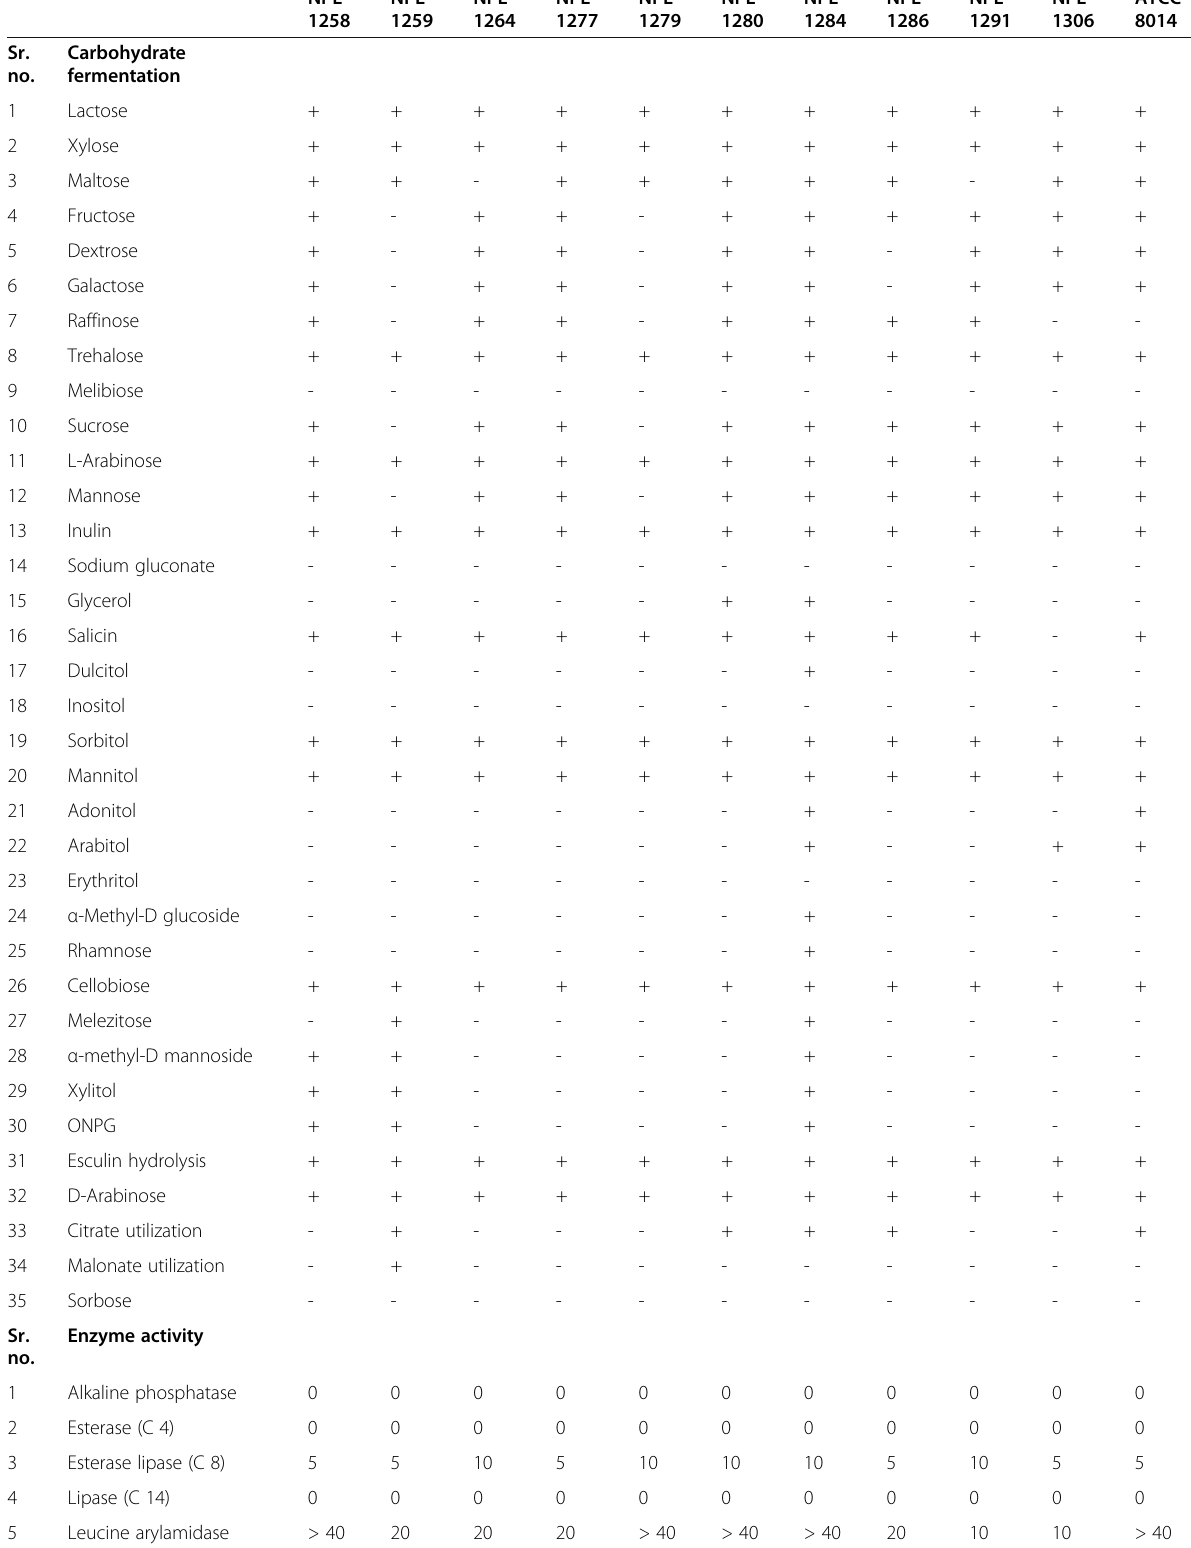
Table 6 Enzyme characterization and carbohydrate utilization of selected